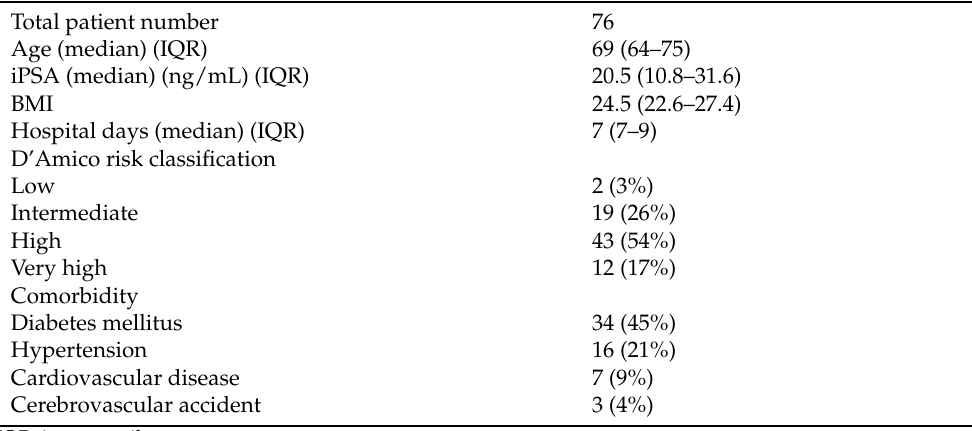
Table 1. Demographic characteristics of patients with locally advanced prostate cancer before